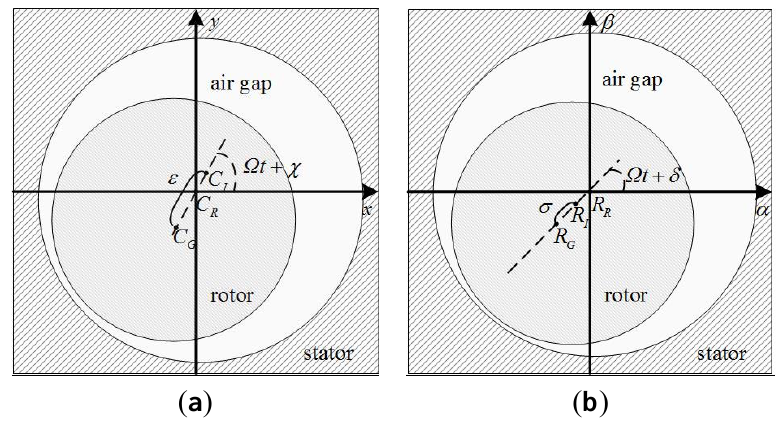
Figure 8. The synchronous displacement relationships of the geometric, inertial, and rotational axes: ( a ) translation; ( b ) rotation.